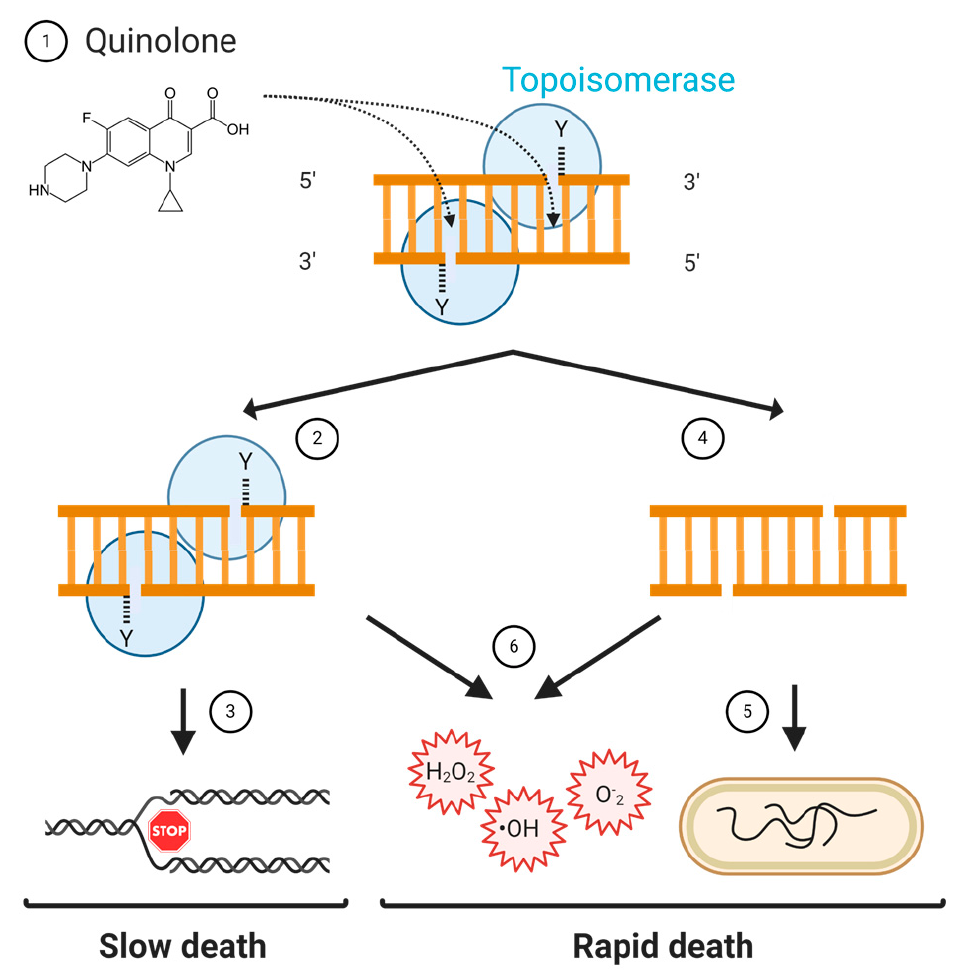
Figure 6. Model of quinolone lethality. (1) Quinolones stabilise the topoisomerase-DNA cleavage complex in which there is a double-strand break. (2) If the cleavage complex is not resolved, (3) replication and transcription cannot happen, which causes slow bacterial cell death. (4) If the topoisomerase is removed, the double-strand break is free, and if left unrepaired, (5) it leads to the fragmentation of the chromosome, which causes rapid bacterial cell death. (6) The stabilised cleavage complex, or the removal of the topoisomerase from the cleavage complex, might lead to the accumulation of reactive oxygen species (ROS) that can cause rapid bacterial cell death.